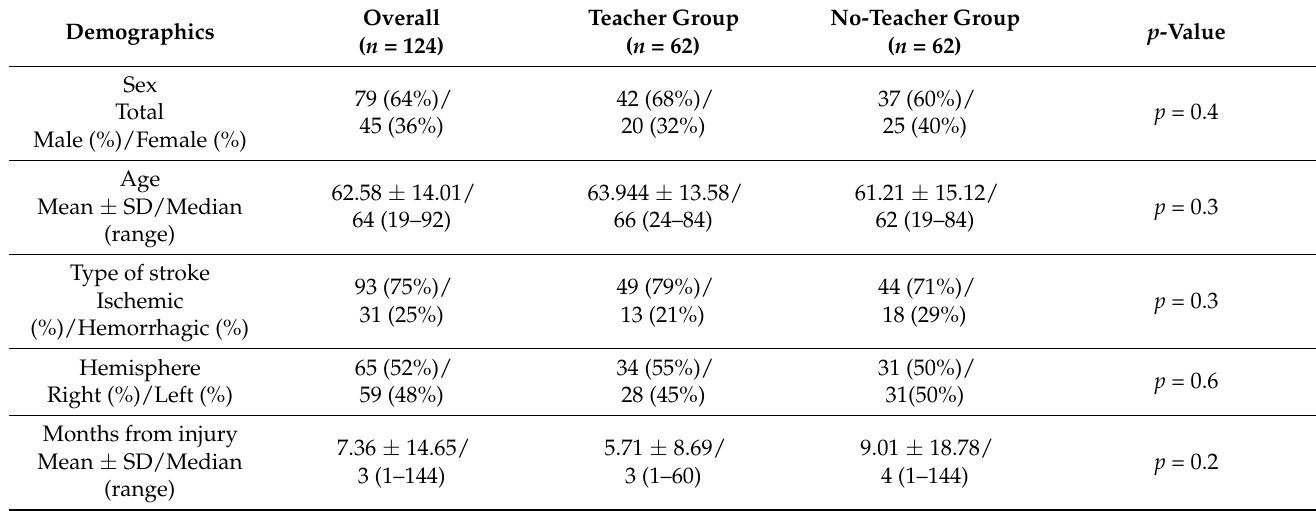
Table 1. Characteristics of the teacher, and no-teacher groups at